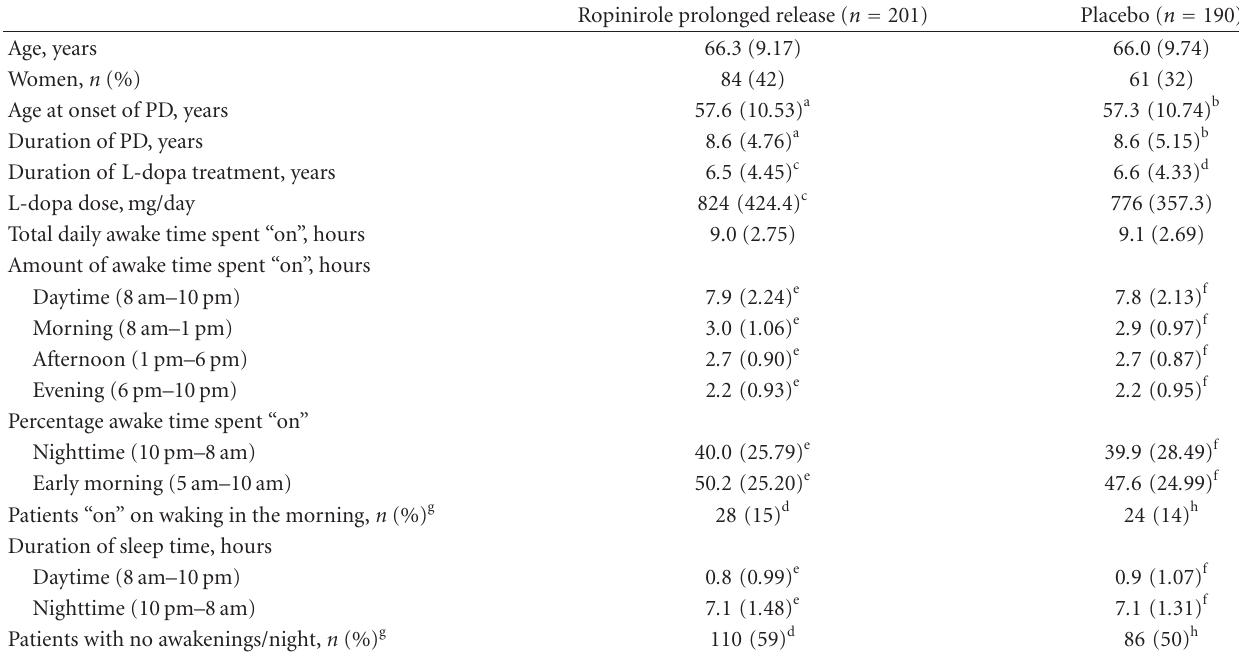
Table 1: Demographics and baseline characteristics of patients (intent-to-treat population).